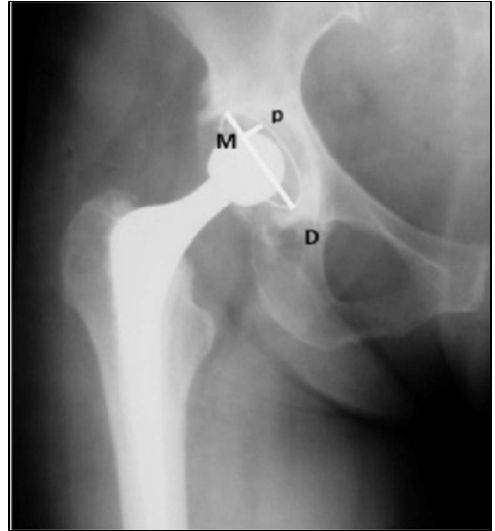
Figure 3. Radiographic areas of acetabular displacement, proposed by DeLee and Charnley, represented in the angle of lines M and D (1976) [43].